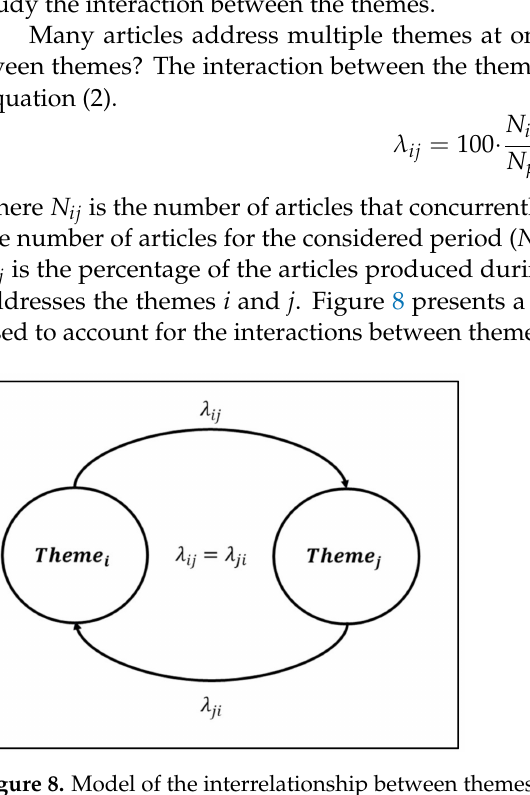
Figure 8. Model of the interrelationship between themes (source: